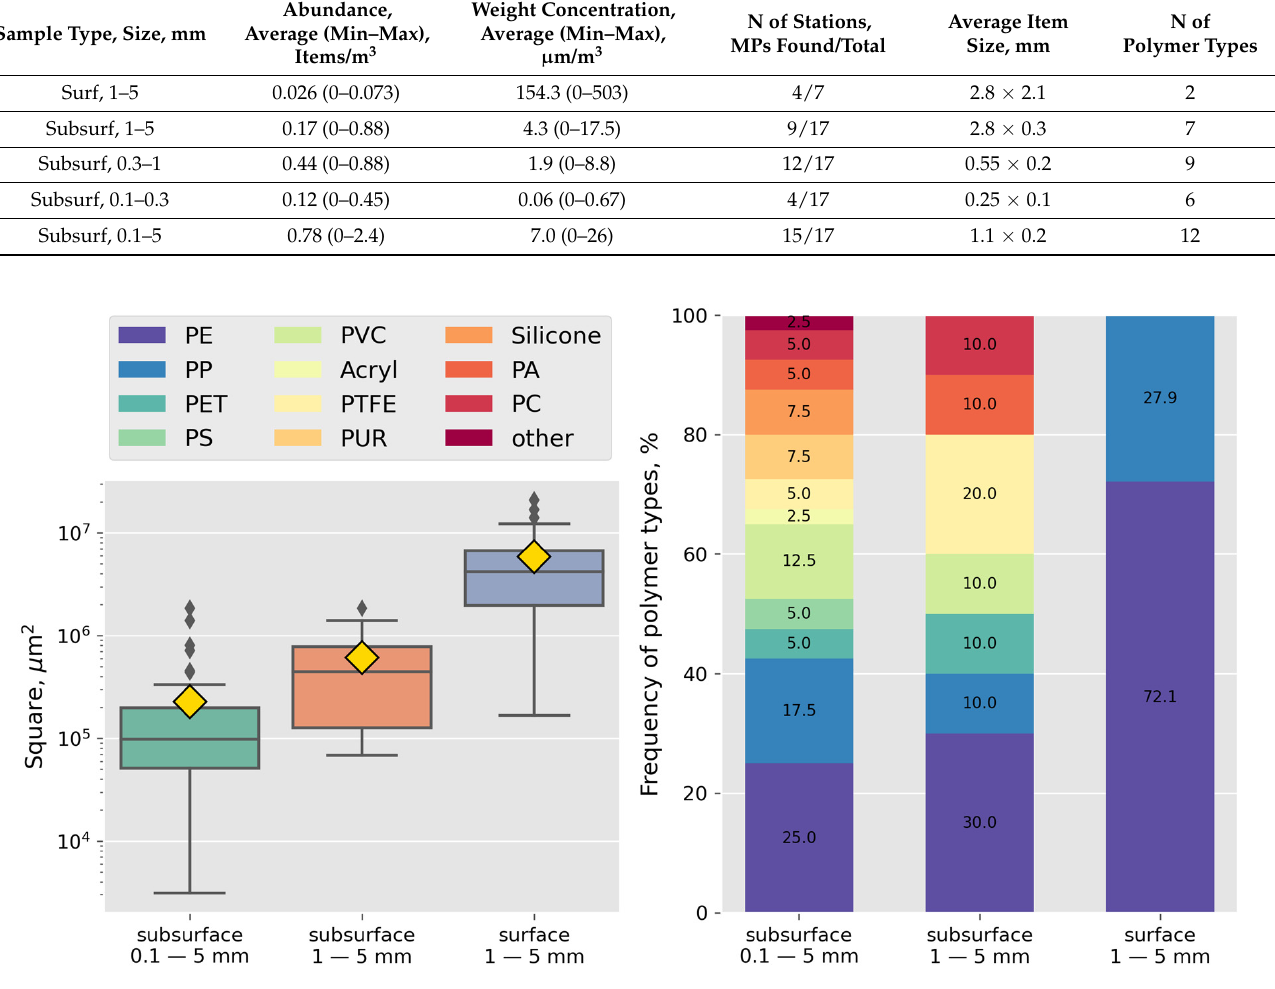
Table 1. Microplastics characteristics for different sampling methods and size fractions.